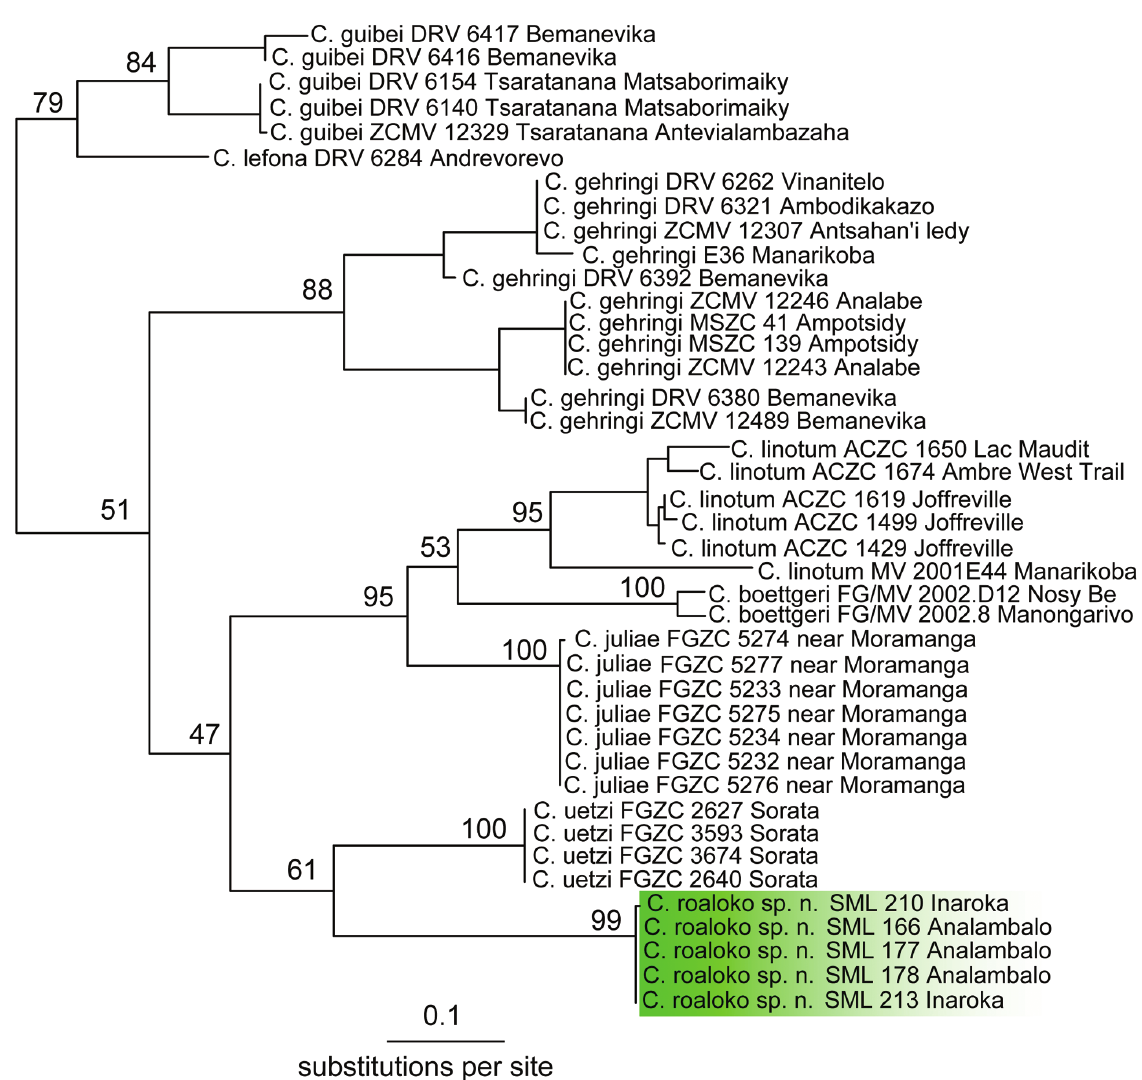
Figure 2. Maximum-likelihood tree of the Calumma boettgeri complex, based on 513 base-pairs of the mitochondrial ND2 gene. Nodal support values indicate the proportional support from 1000 rapid bootstrap replicates. Support values for intra-specific rela - tionships are not shown. Outgroup ( C. oshaughnessyi FGZC 4577) not shown for graphical